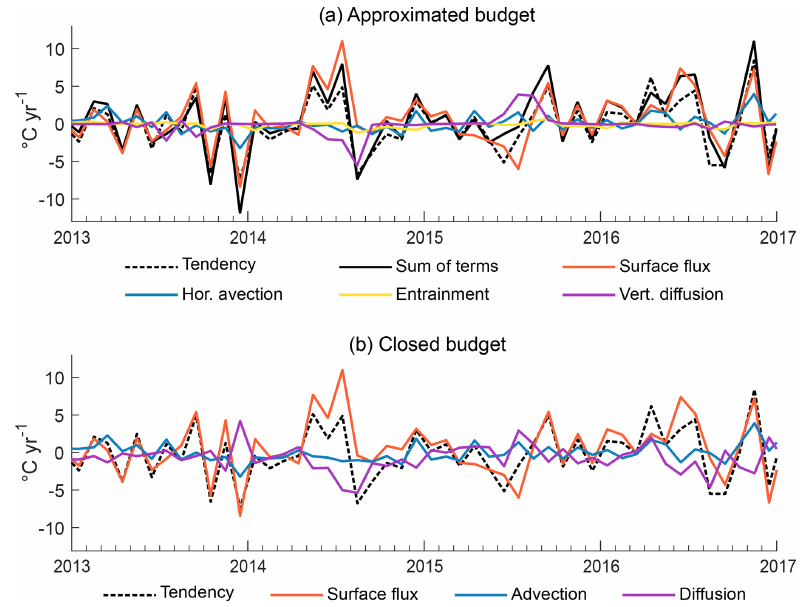
Figure 6. (a) Anomalies in the dominant terms of the mixed-layer temperature budget ( ◦ Cyr − 1 ) relative to the 1992–2015 monthly climatol- ogy, averaged over the cold blob region. (a) The approximated budget computed via Eq. (1), where the dashed black line shows anomalies in the model temperature tendency and the solid black line shows anomalies in the sum of the temperature budget terms driving the temperature change. The remaining lines represent these individual processes: the surface heat flux (orange), horizontal advection (blue), vertical entrain- ment (yellow), and vertical diffusion (purple). The budget is shown in Fig. A1, prior to the removal of the seasonal cycle. (b) Anomalies in the closed mixed-layer budget for